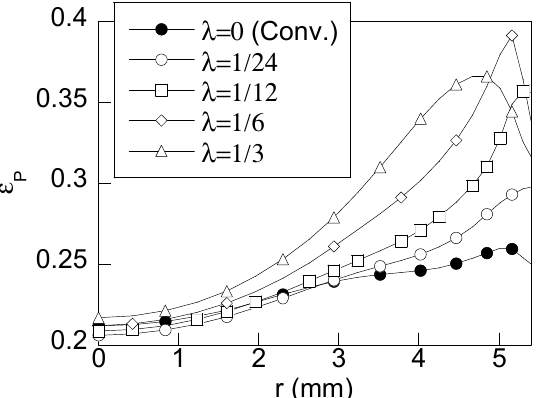
Figure 7. Radial distributions of equivalent plastic strain in cold drawn wires using diverse values of the secondary reduction ratio.